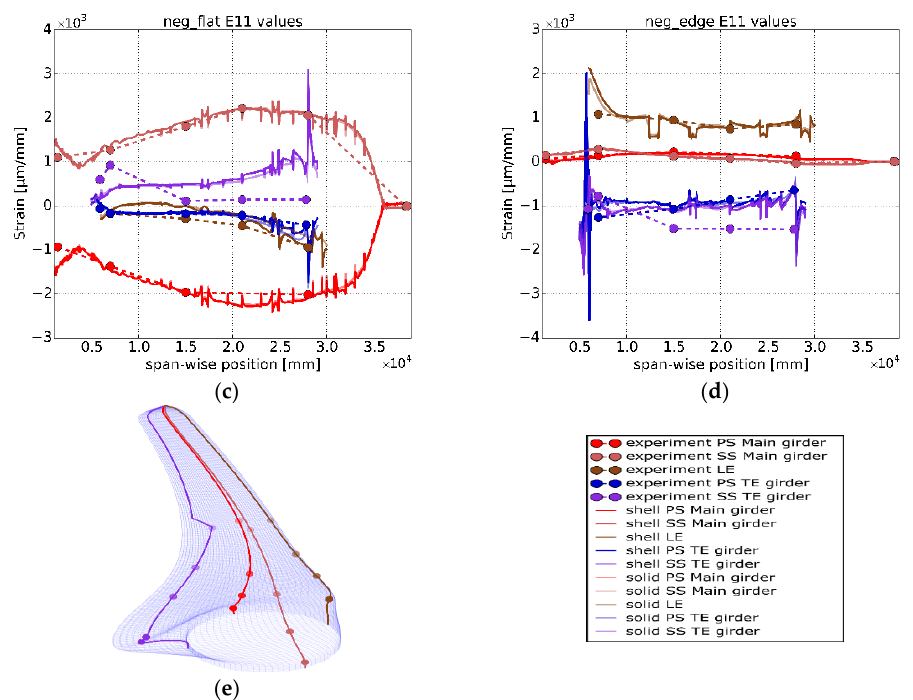
Figure 12. Overview of the true strain in the longitudinal direction along the different paths. ( a ) Positive flatwise load case; ( b ) positive edgewise load case; ( c ) negative flatwise load case; ( d ) negative edgewise load case; ( e ) 3D plot of the path locations on the blade OML surface. Energies 2018 , 11 , x 13 of 18